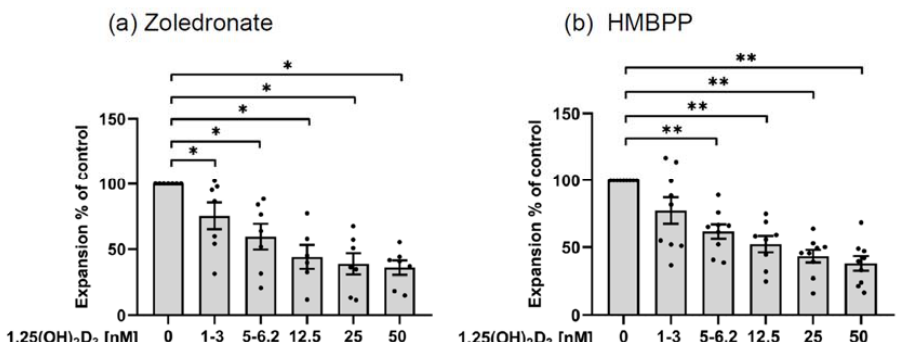
Figure 5. 1,25(OH) 2 D 3 inhibits γδ T cell expansion . PBMC from healthy donors were activated